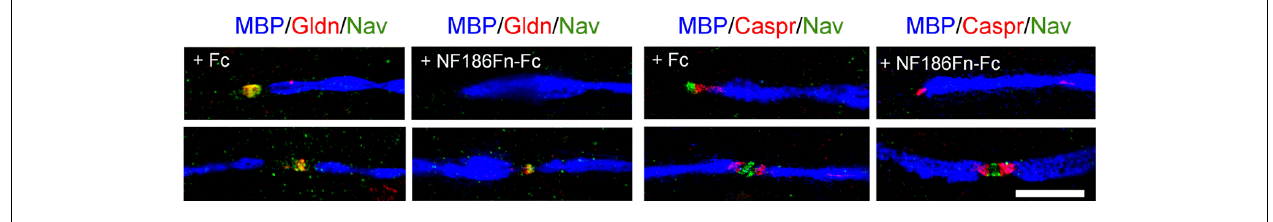
Gliomedin (Gldn) and Nav channels are clustered at hemi-nodes and flanked the paranodes and myelin borders in myelinating co-cultures. Incubation with NF186Fn-Fc abrogated the clustering of Gliomedin and Nav channels at hemi-nodes, but not at mature nodes of Ranvier. This indicated that the interaction between NF186 and Gliomedin is crucial for the formation of hemi-node clusters. Scale bar: 10 μ m. Adapted from Labasque etal.